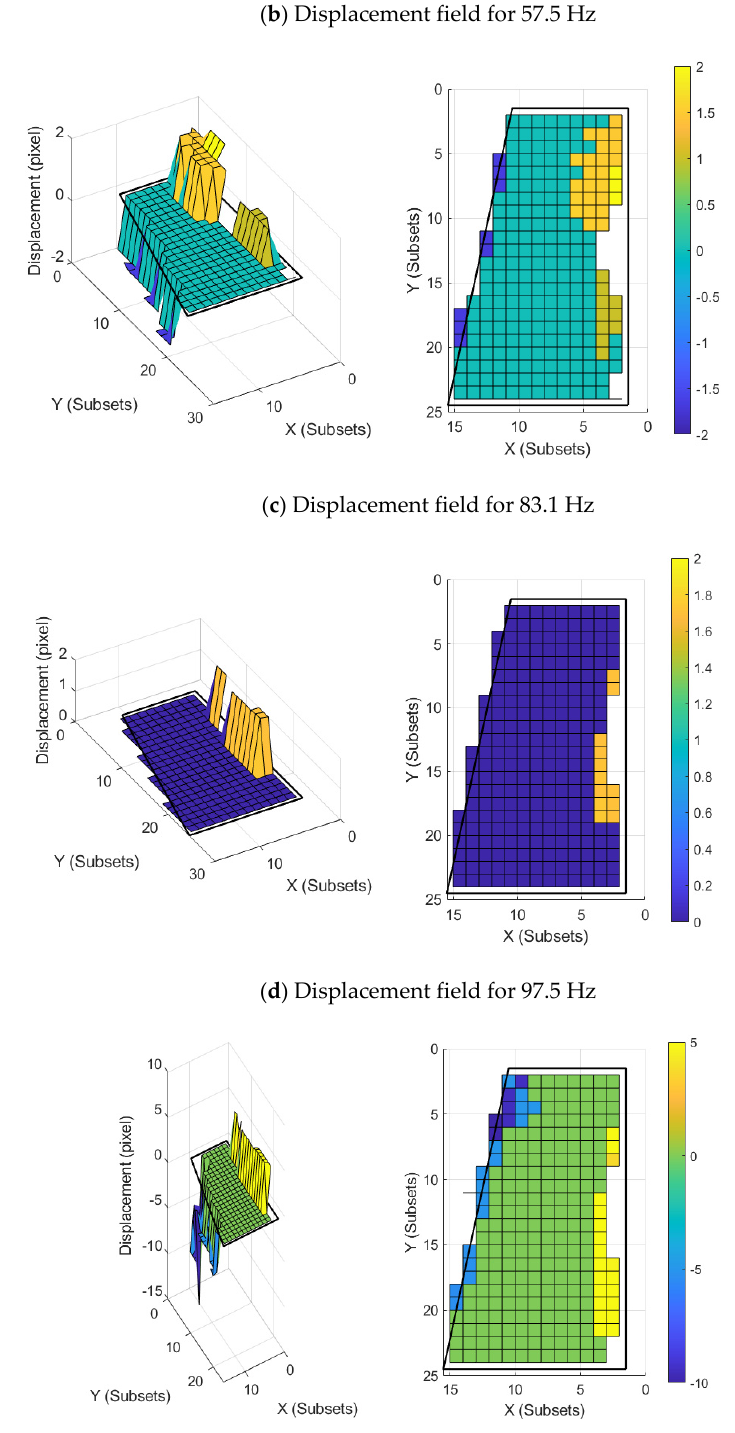
Figure 8. Static representations of the vibration mode for the first relevant natural frequencies from two different perspective points: ( a ) displacement field for 42.8 Hz, ( b ) displacement field for 57.5 Hz, ( c ) displacement field for 83.1Hz and ( d ) displacement field for 97.5 Hz. The color bars represent the displacement field (pixels).